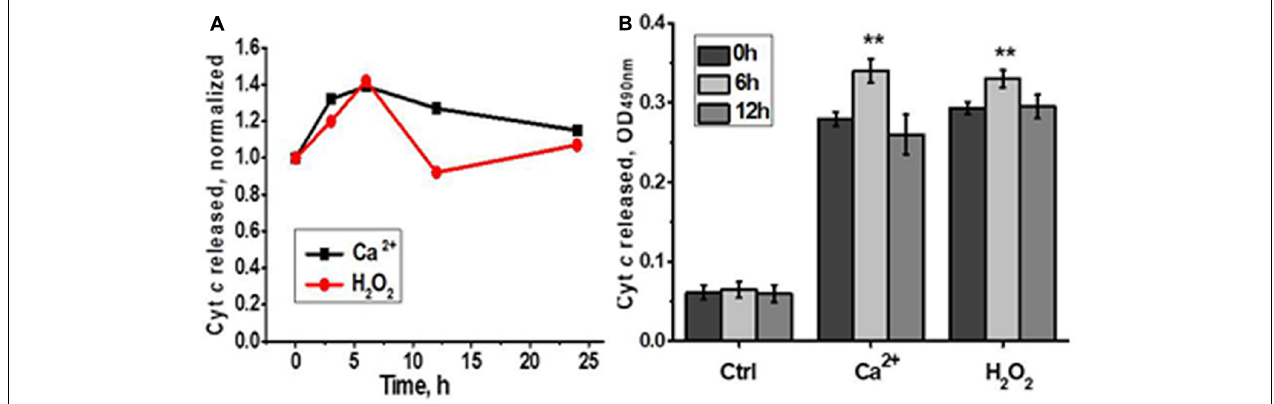
FIGURE 5 | Cyt c released from liver mitochondria of laparotomized rats under the effect of either Ca 2 + (0.9 µ M) or H 2 O 2 (0.5 mM). (A) Normalized data for one rat per each time point; (B) raw data for three rats per each time point; mean ± SE; ∗∗ p < 0.005 compared to pre-operation state (0